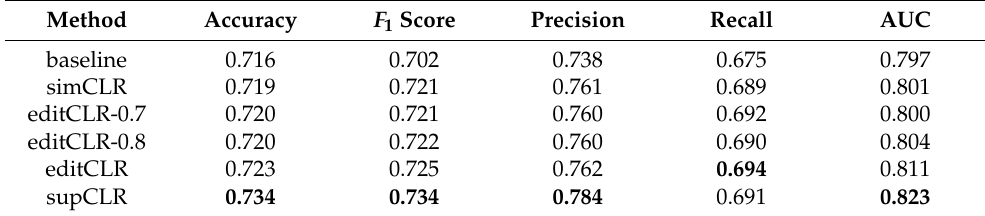
Table 2. Performance results on DEEPre dataset.